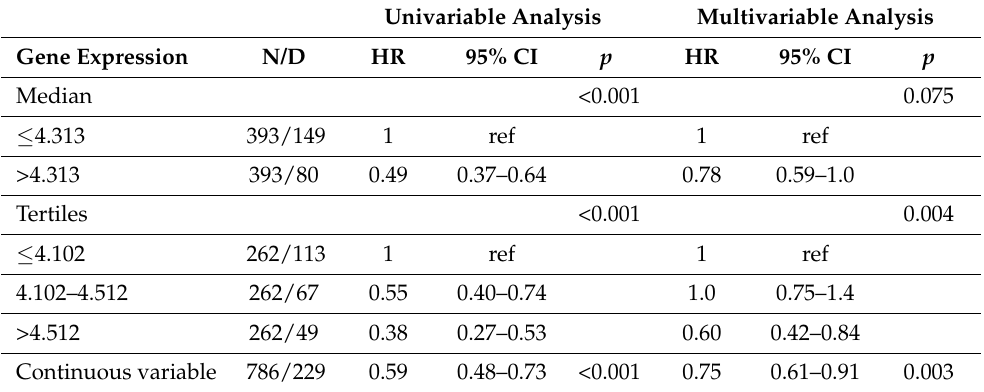
Table 21. Overall Survival of 786 NB patients in relation to LPIN1 expression levels evaluated by the Cox regression model.